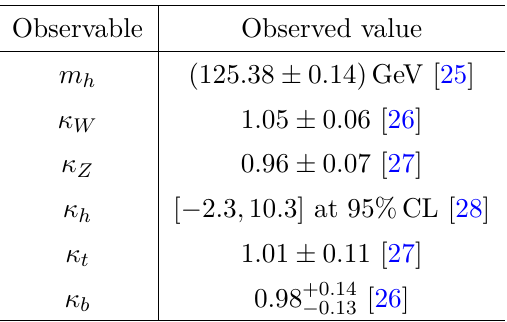
Table 1. Experimental values of the Higgs mass and coupling multipliers used in our